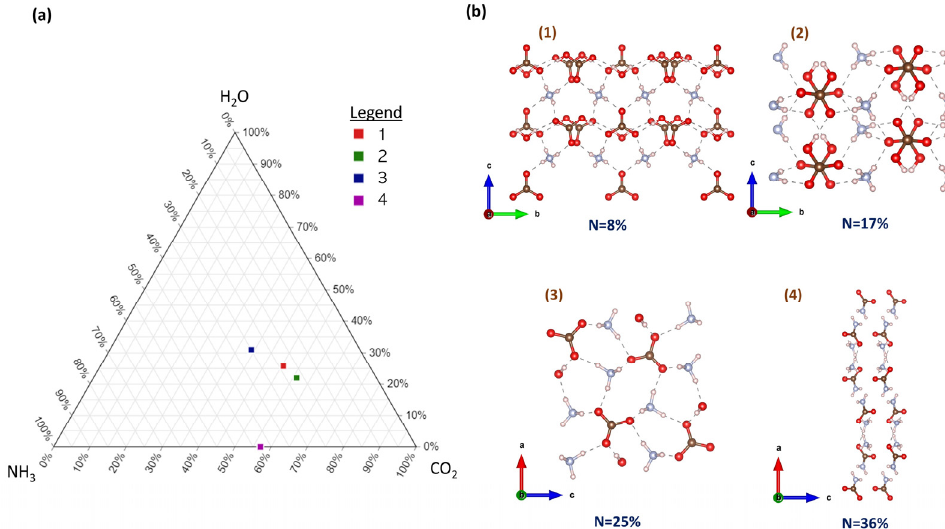
Figure 2. ( a ) The (CO 2 –NH 3 –H 2 O) ternary system with the phases of ( 1 ) ammonium sesquicarbonate monohydrate, ( 2 ) ammonium bicarbonate, ( 3 ) ammonium carbonate monohydrate, and ( 4 ) ammonium carbamate; ( b ) the crystal structure of the different phases of AC mentioned in part ( a ), with the same order. The total theoretical nitrogen content in each material is also shown.